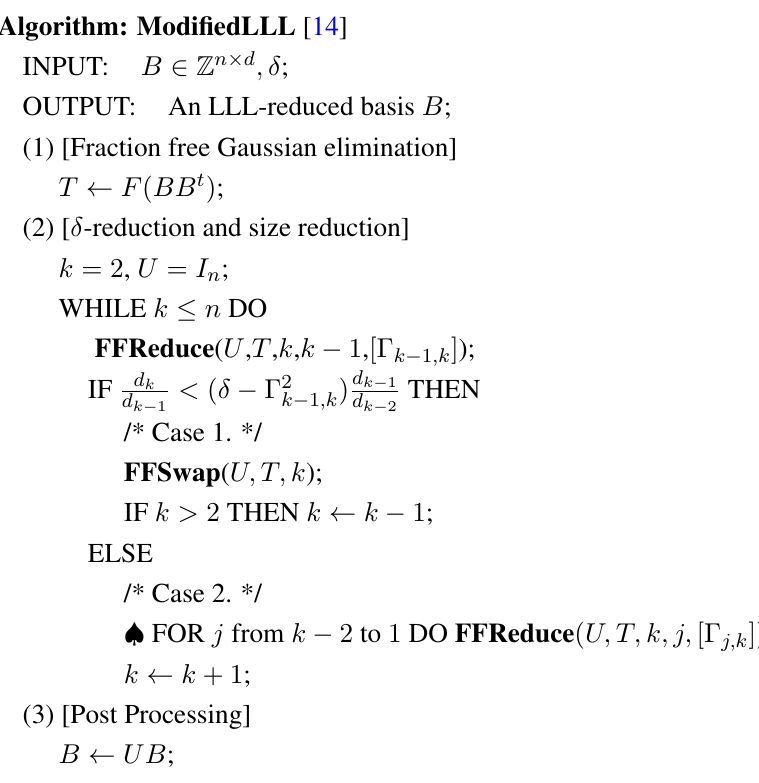
Figure 5. Modified LLL Basis Reduction Algorithm.